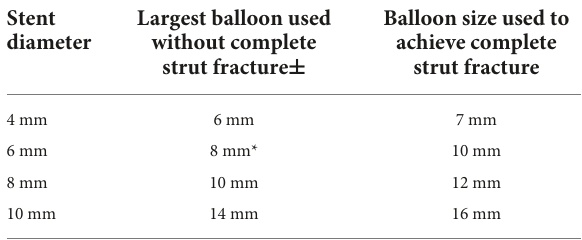
TABLE 4 Diameter of angioplasty catheter used for complete fracture of all struts by stent size. Stent Largest balloon used diameter without complete strut fracture ±